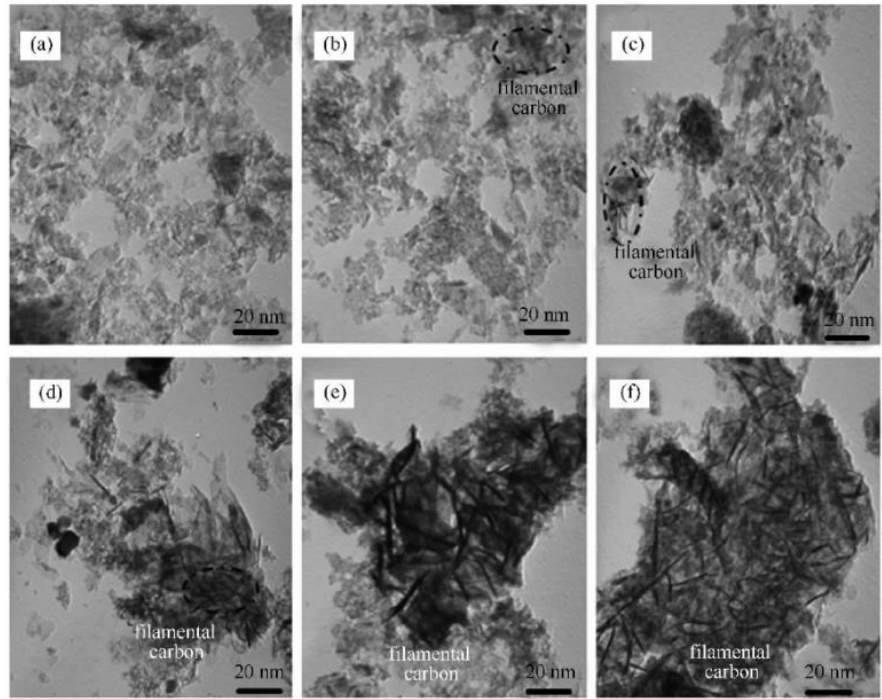
Figure 3. TEM photos of different Ni-Al 2 O 3 catalysts after CO 2 -CH 4 reforming reaction for different times [49]. ( a – f ) Fresh catalyst and catalyst after reaction for 0.5 h, 1 h, 2 h, 5 h, and 10 h, respectively.